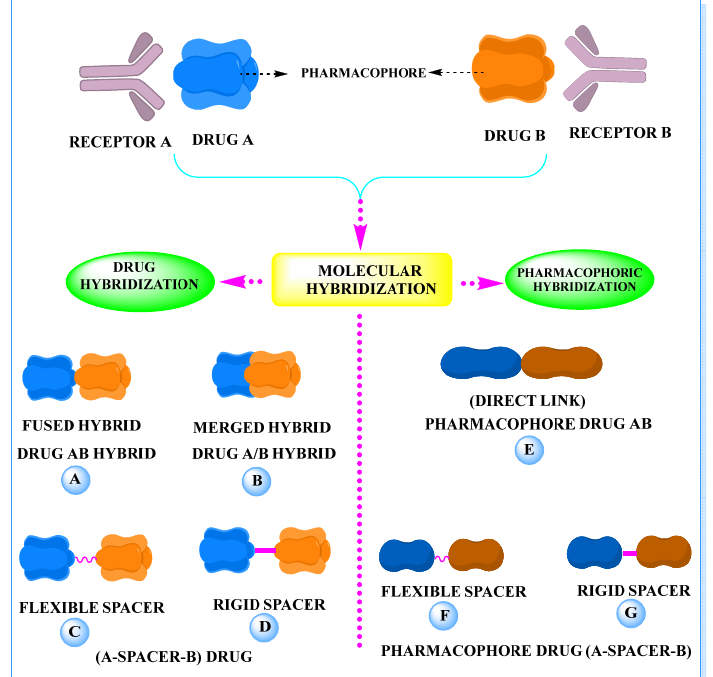
Figure 1. Different methods of molecular hybridization. ( A ) Drug A and B are directly linked to each other; ( B ) brug A and B are merged with each other; ( C ) drug A and B are connected by a flexible spacer; ( D ) drug A and B are connected through a rigid spacer; ( E ) two pharmacophoric moieties are directly connected to each other; ( F ) two pharmacophoric moieties are connected by a flexible spacer; ( G ) two pharmacophoric moieties are connected by a rigid